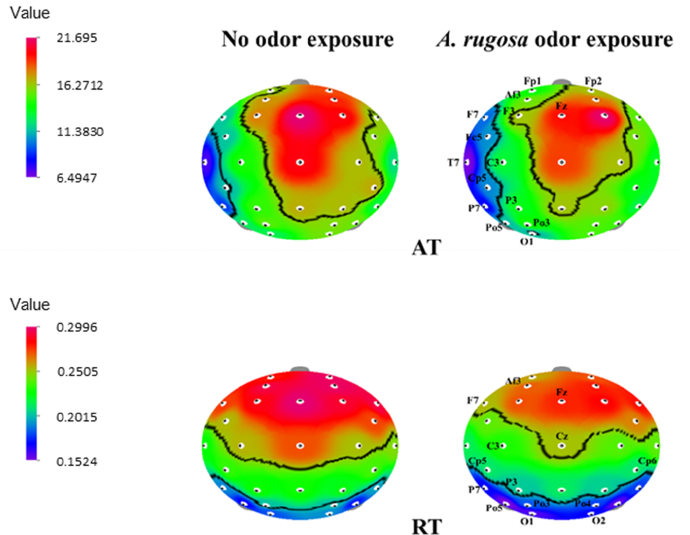
Figure 2. The t-mapping of EEG power spectrum changes during no odor and A. rugosa essential oil odor conditions. AT, absolute theta; RT, relative beta. The marked sites in the t-mapping denote the significant changes during exposure to A. rugosa essential oil. On the other hand, the RA power spectrum significantly increased ( p < 0.05) in the temporal region (Cp5, and Cp6), parietal region (P8, P3, and P4), and overall occipital region (Po5, Po6, Po3, Po4, O1, and O2). Slow alpha waves increased significantly in the occipital lobe (Po3, O1, and O2) ( p < 0.05). Furthermore, SEF50 values showed that the left frontal regions (Fp2 and Af3), frontal regions (F3 and Fz), and temporal region (Cp6) significantly increased. The ASEF index significantly increased at the right temporal region, Cp6 ( p < 0.05) (Table 4 and Figure 3). Table 4. Significant changes of RA, RSA, SEF50 and ASEF power spectra between no odor exposure and A. rugosa essential oil odor